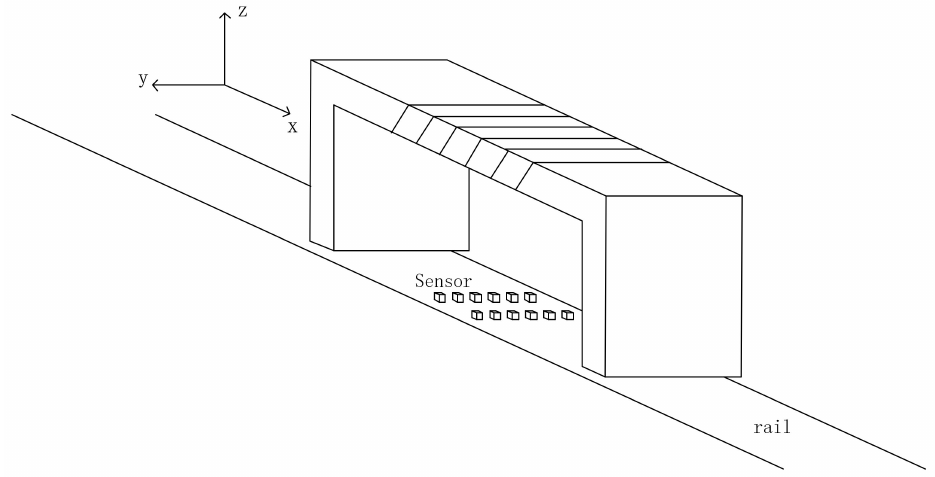
Figure 2. Array sensors